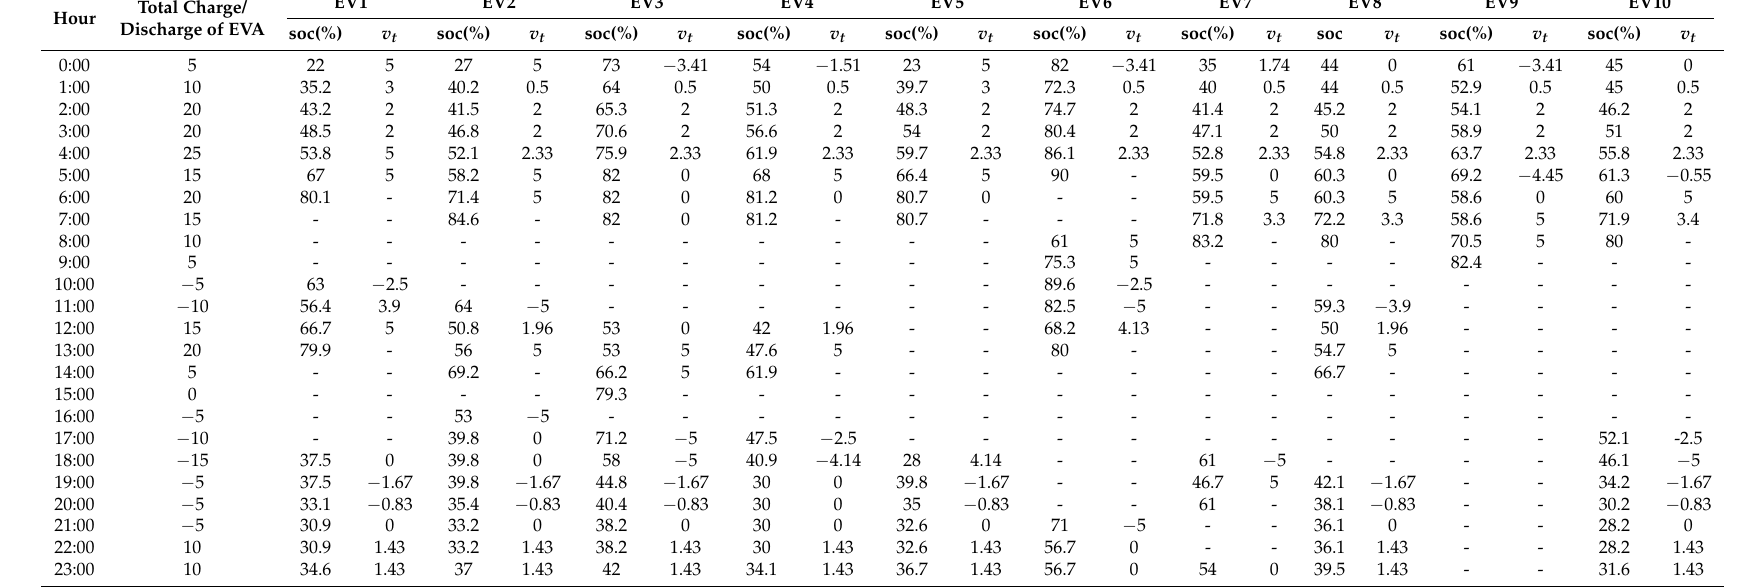
Table 4. A case of EVs secondary scheduling